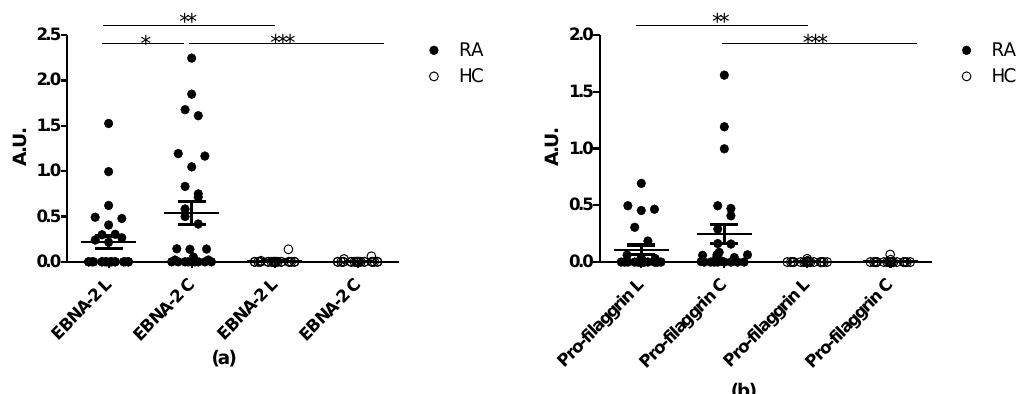
Figure 5. Reactivity of rheumatoid arthritis (RA) samples and healthy control (HC) samples to pro-filaggrin (25 RA and 25 HC samples) and EBNA-2 (28 RA and 28 HC samples) peptides in their linear and cyclic conformation. ( a ) Reactivity of RA and HC sera to citrullinated cyclic and linear EBNA-2 peptides. ( b ) Reactivity of RA and HC sera to citrullinated cyclic and linear pro-filaggrin peptides. A.U. were defined as absorbances normalized relative to a positive RA control pool. *** p < 0.001, ** p < 0.01, * p < 0.05.